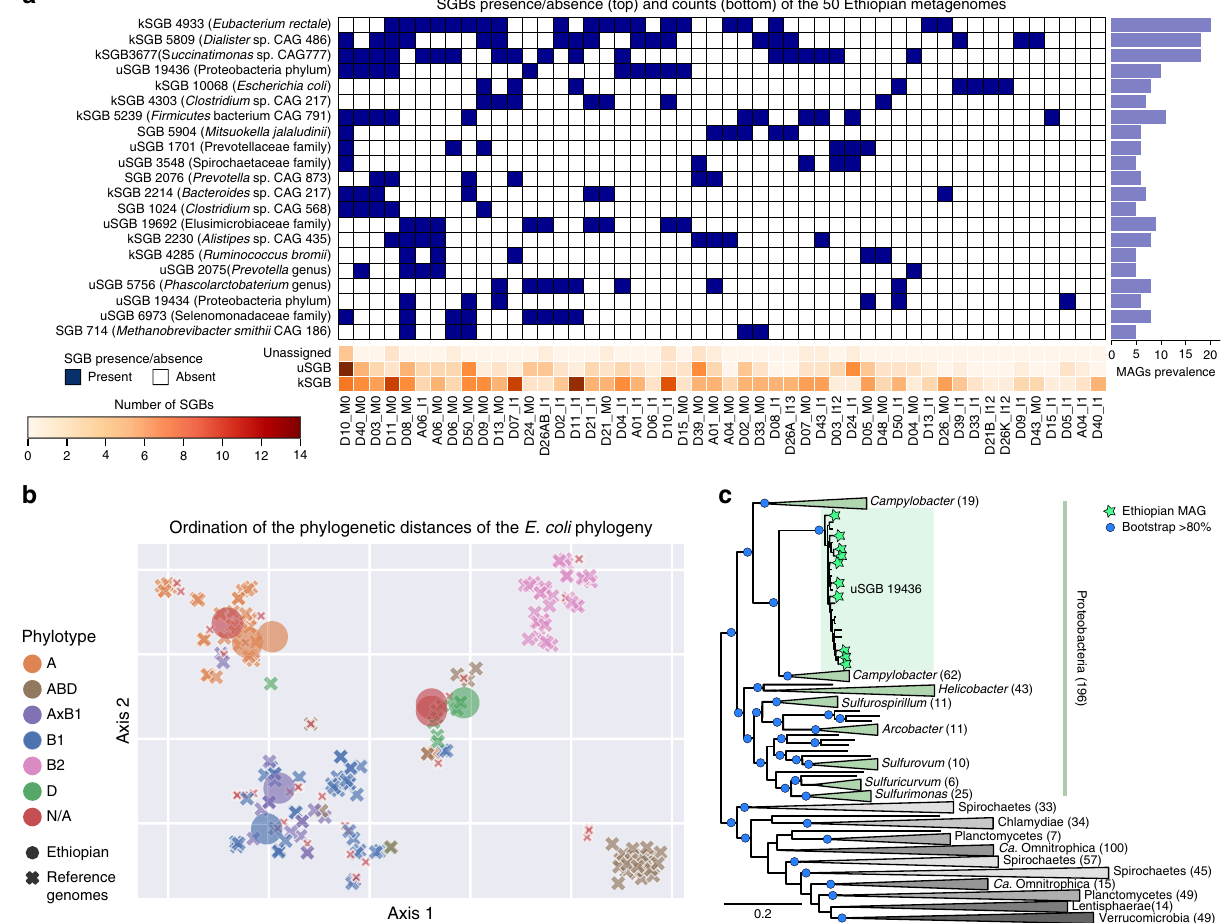
Fig. 3 Phylogenetic analysis of MAGs from 50 rural Ethiopian metagenomes. a Occurrence of the 20 most prevalent SGBs among 50 previously sequenced Ethiopian gut metagenomes highlights the presence of many previously identi fi ed but largely uncharacterized species-level genome bins (uSGBs) and the identi fi cation of few additional MAGs (unassigned) that are not recapitulated in any already de fi ned SGB. The presence/absence pro fi les are clustered using average linkage with Euclidean distances. b Multidimensional scaling ordination using the t-SNE algorithm on phylogenetic distances from PhyloPhlAn 3.0's tree of eight Ethiopian E. coli MAGs (kSGB 10068) integrated with 200 automatically selected E. coli reference genomes using 3246 UniRef90 gene families for phylogenetic reconstruction. c PhyloPhlAn 3.0 phylogeny of Ethiopian MAGs assigned to uSGB ID 19436 including all reference genomes for the closest phyla (589 in total) according to the prokaryotes tree-of-life in Fig. 4. Phylogeny reconstruction used 400 universal markers selected by PhyloPhlAn 3.0 for deep-branching phylogenies. Portions of the tree collapsed are labeled and numbers in parentheses represent the number of genomes in the collapsed subtrees. Uncollapsed phylogeny is available in Supplementary Fig.